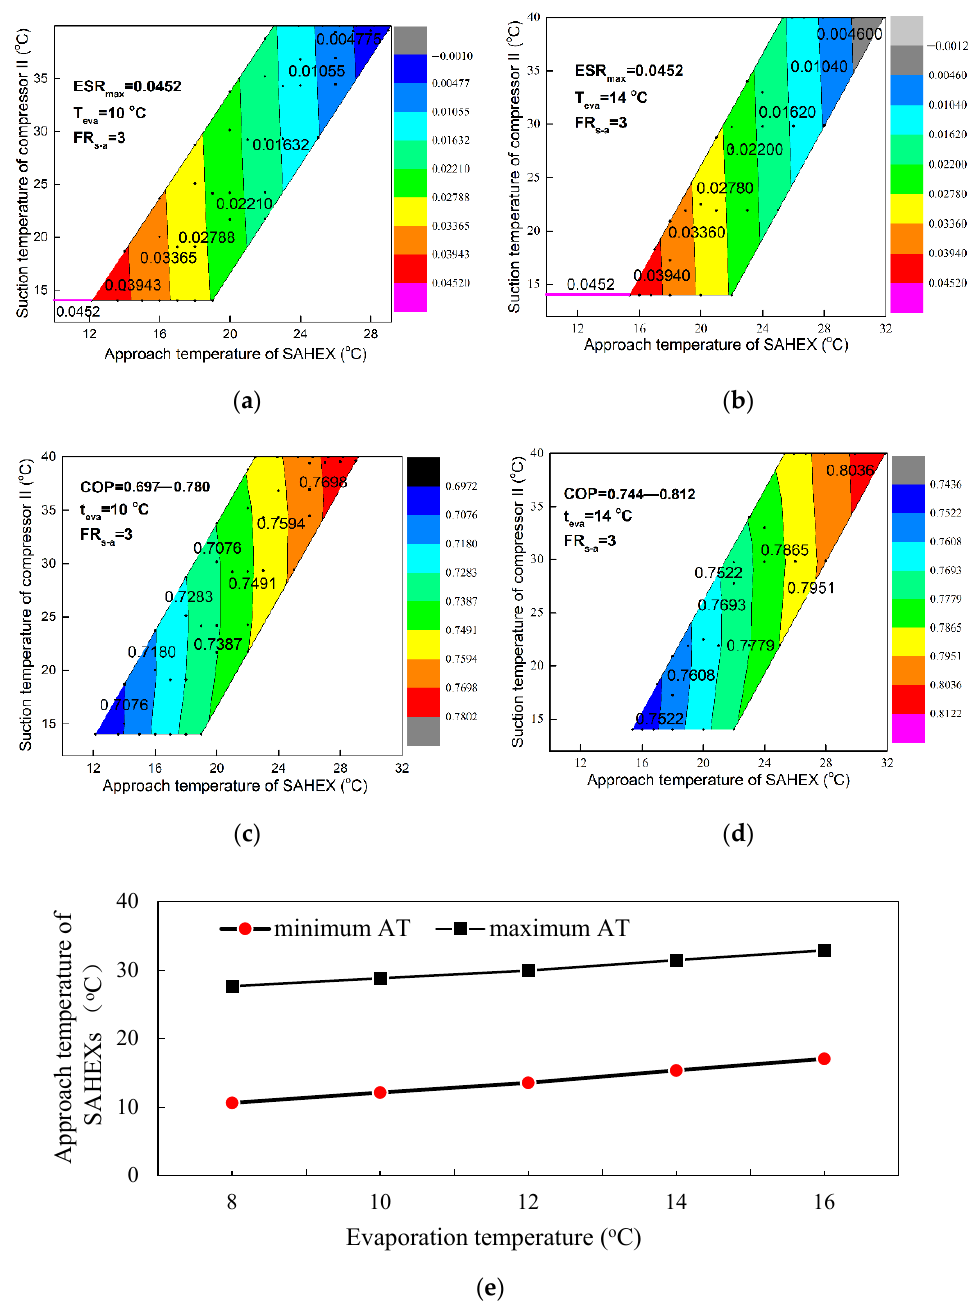
Figure 8. Influence of evaporation temperature on ESR and COP : ( a ) ESR at T eva = 10 °C, FR s-a = 3; ( b ) ESR at T eva = 14 °C, FR s-a = 3; ( c ) COP at T eva = 10 °C, FR s-a = 3; ( d ) COP at T eva = 14 °C, FR s-a = 3; ( e ) minimum and maximum AT sahex at different T eva .